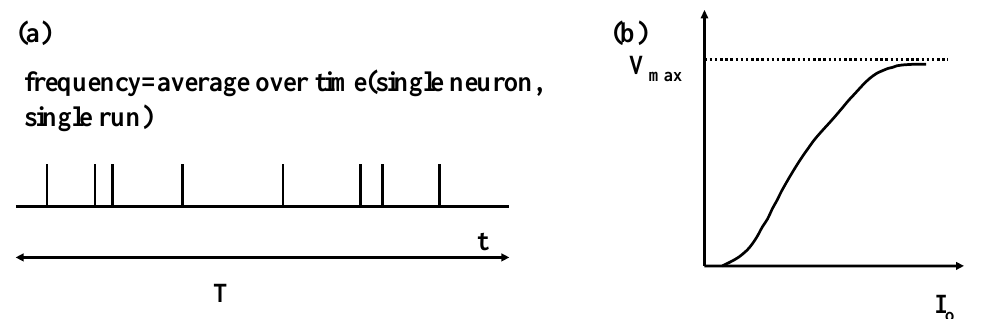
Figure 6. ( a ): Spiking firing frequency defined by event averaging. ( b ): Schematic diagram of the gain